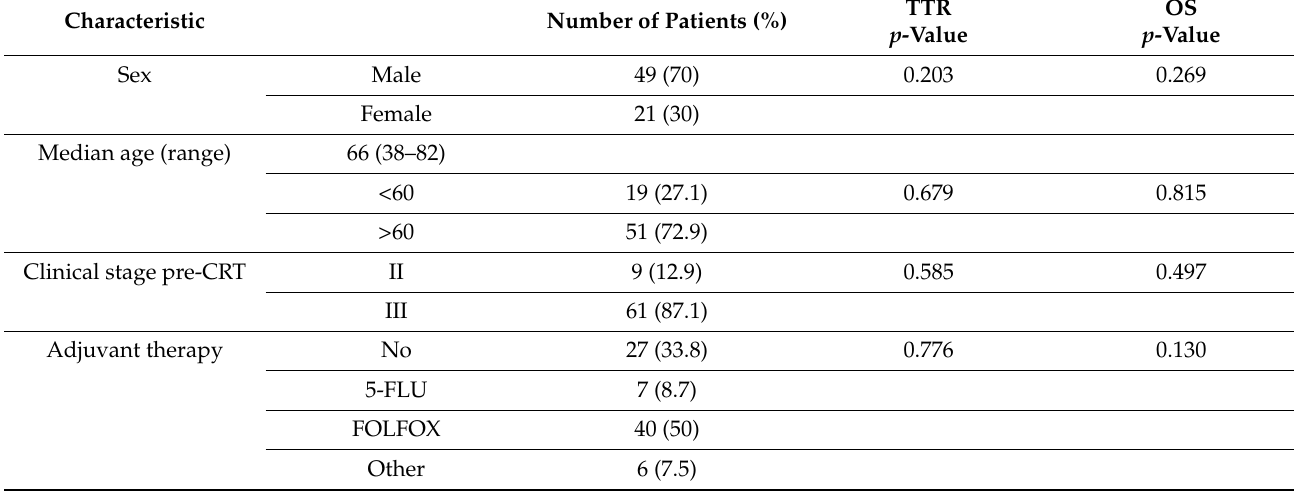
Table 1. Main clinical characteristics of the 70 patients included in the study with their associated time to relapse (TTR) and overall survival (OS) according to the univariate analyses (log rank). Significant p -values are shown in bold. RC: rectal cancer; CRT: